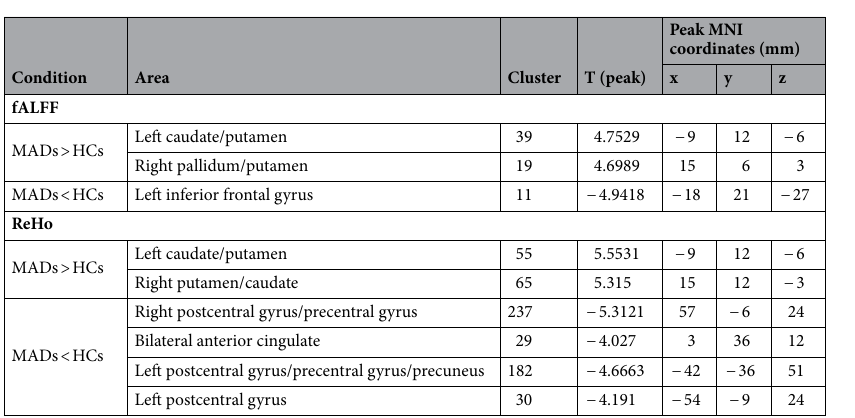
Table 2. Significant between-group differences in fALFF and ReHo maps. MADs methamphetamine- dependent subjects, HCs health control subjects, MNI Montreal Neurological Institute.